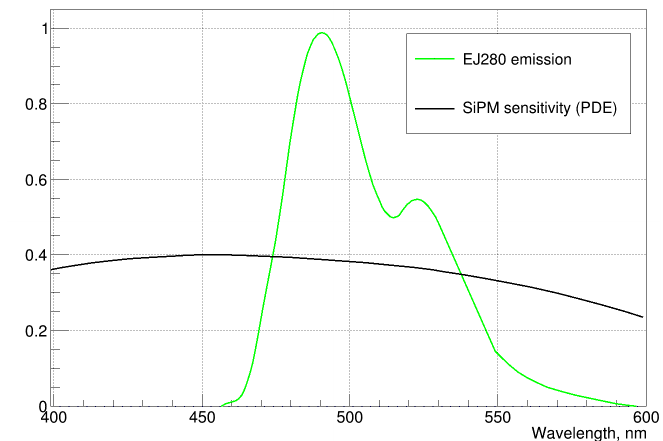
Figure 6. Spectral relationships: WLS emission spectrum [17] (in a.u.) and SiPM spectral dependence of PDE